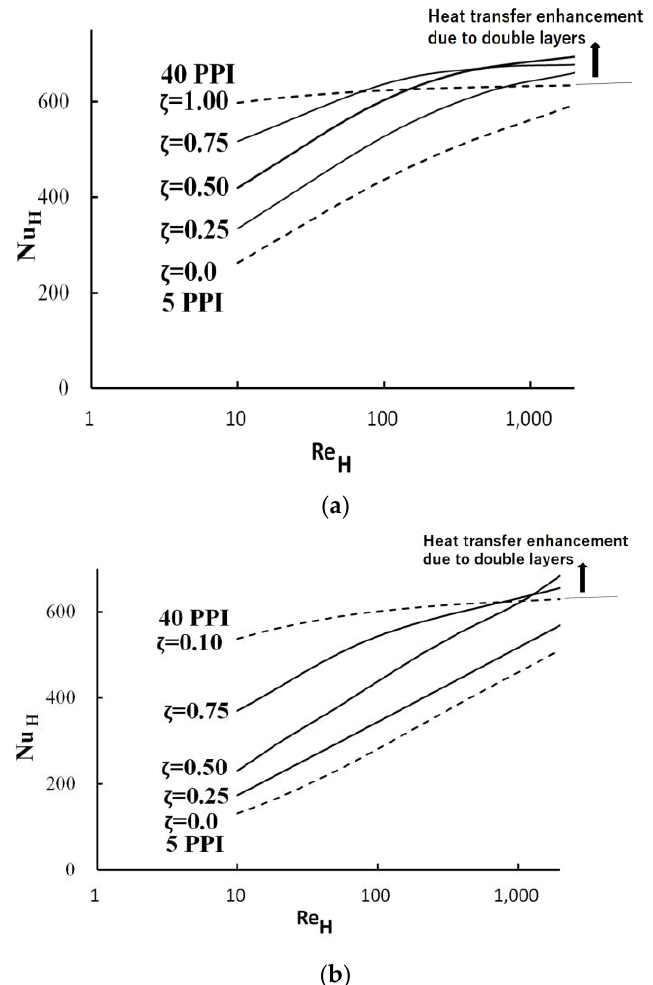
Figure 10. The change of 𝑁𝑢 𝐻 of channel with two-layer metal foams with channel Reynolds number for different values of sublayer thickness ( a ) LHC, ( b ) SHC.